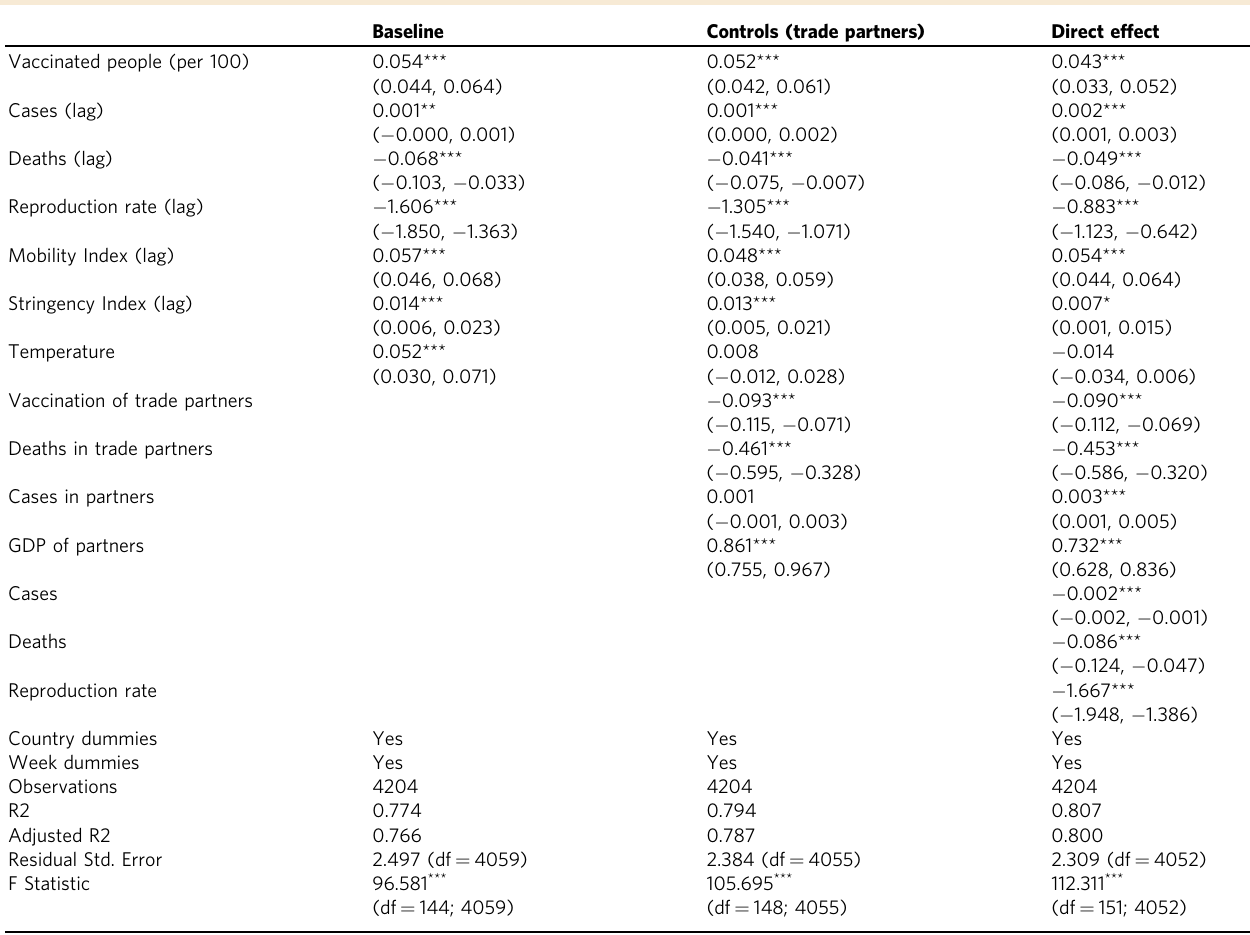
Table 2 Regression results for vaccination-GDP